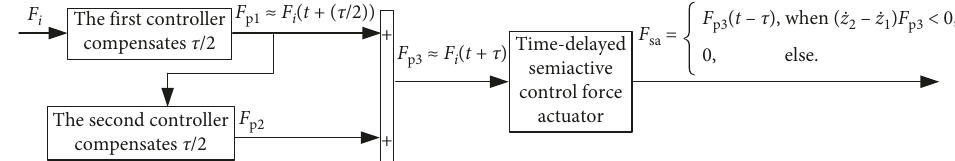
Figure 3: Principle of the STLQG control system.